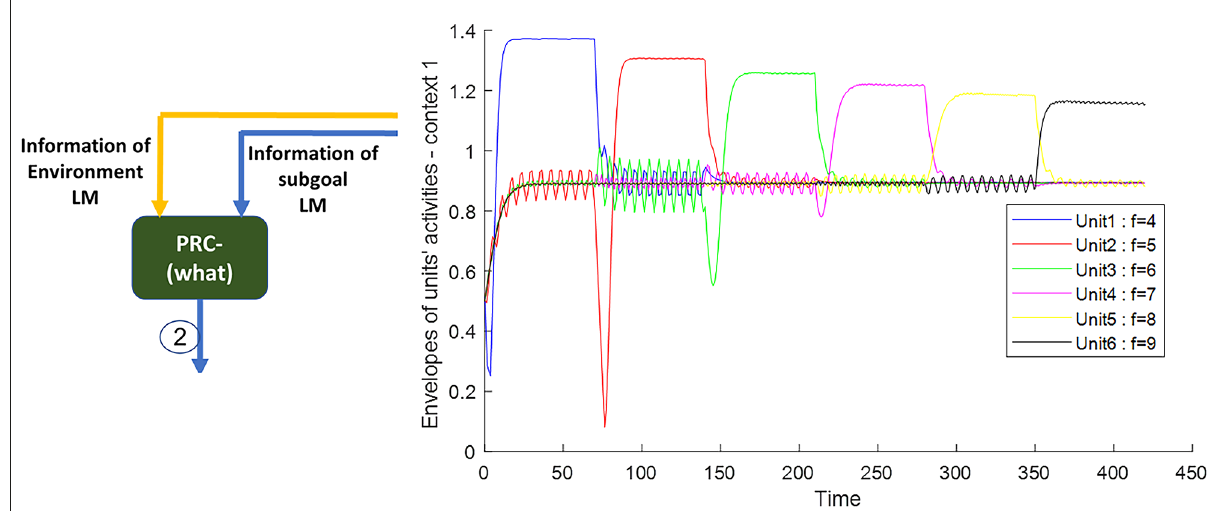
FIGURE5 The outputs of the Van-der-pol neuron model which is used in this article to model neuronal ensembles in the PRC region. The simulation results are shown as neuronal units’ responses to input excitations (landmarks 1–6), in the order of encountering based on the route of related context. Right column: amplitude envelop for neuronal units’ responses to input excitations for context 1. The parameters for the Van-der-pol model in this simulation are λ = 0.2, B 1,...,6 = 1.5, A s = 1, P 1,...,6 = 4,5,6,7,8,9, ω s = 4,5,6,7,8,9. 1,...,6